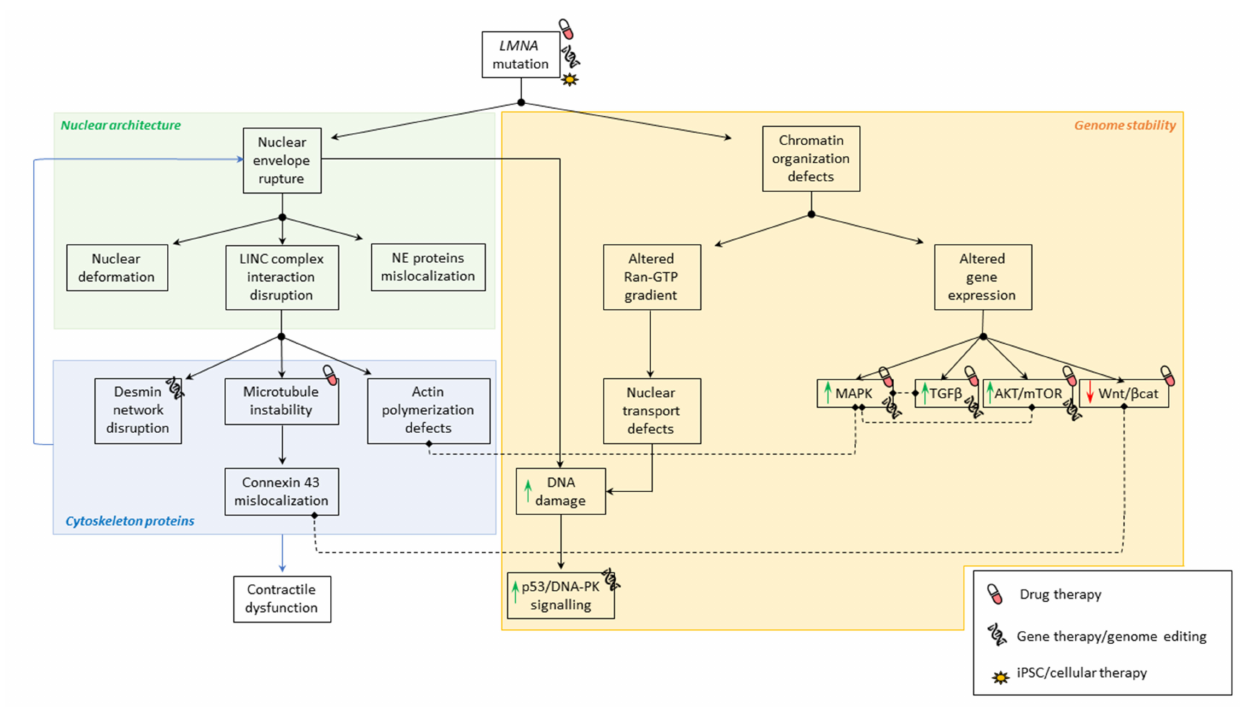
Figure 1. Pathophysiological mechanisms involved in SML. Summary of physiological mechanisms affected in striated muscle laminopathies due to LMNA mutations. Black solid arrows indicate the consequence of altered mechanisms. Doted lines indicate correlation between